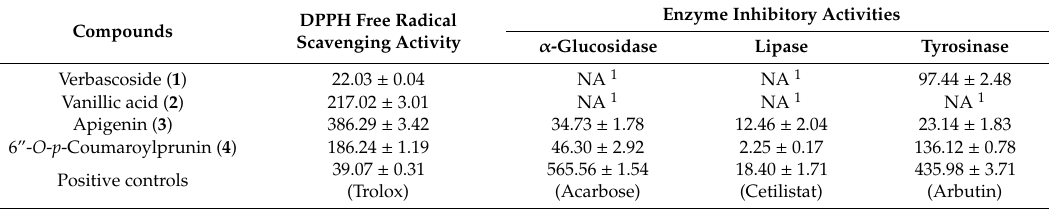
Table 4. IC 50 ( µ M) values of compounds isolated from B. linariifolia for their bioactivities.